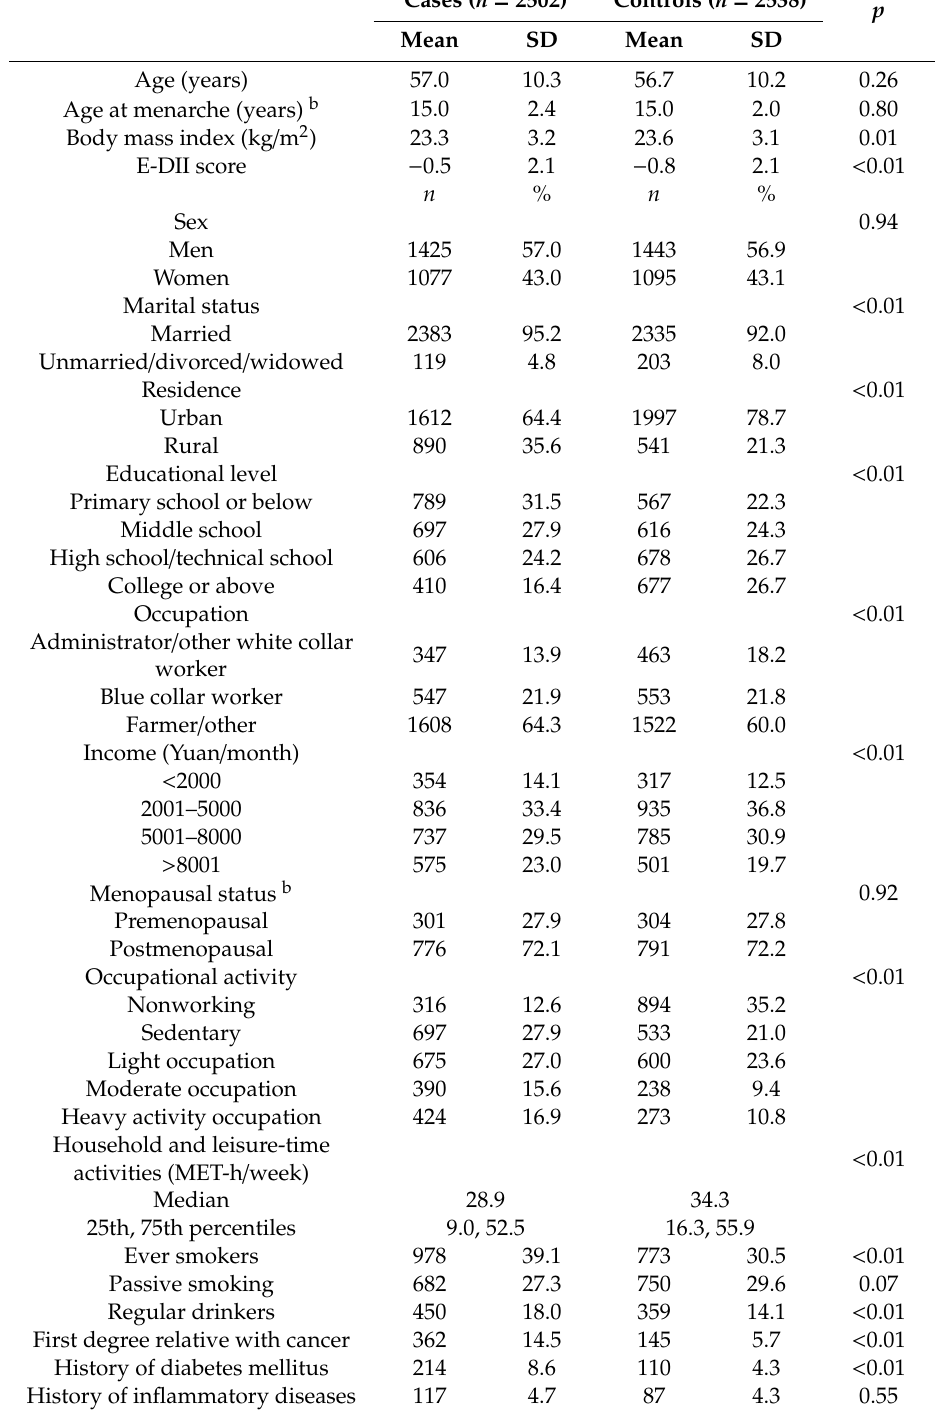
Table 1. Characteristics and selected risk factors of colorectal cancer cases and controls in a Chinese case-control study, 2010–2019 a